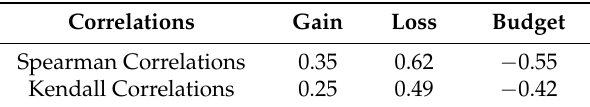
Figure 8. The permafrost map (permafrost data can be downloaded from the National Snow and Ice Data Center [35]). Table 2. The correlation